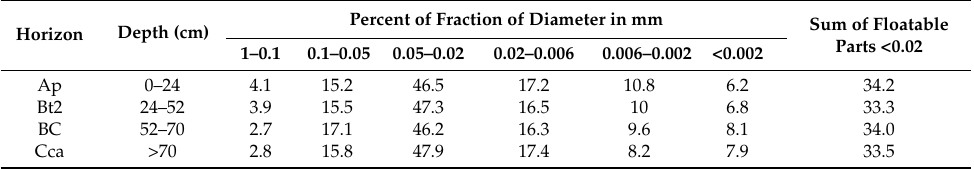
Table 3. Soil granulometric composition.